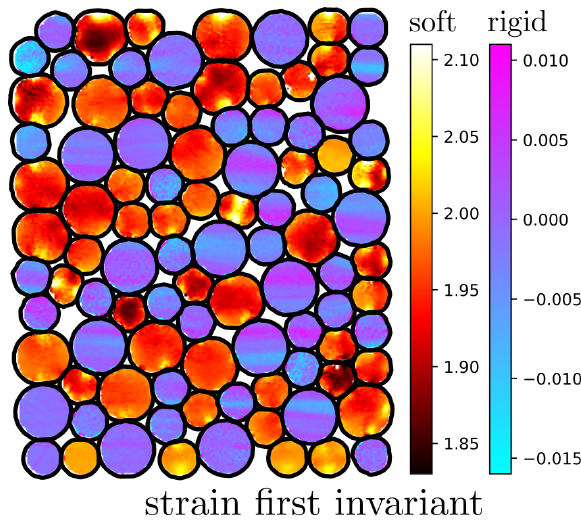
Figure 3. Local observables. Field of the fi rst invariant of the right Cauchy-Green strain tensor ( C ) for soft particles and of the in fi nitesimal strain tensor ( ε ) for rigid particles. These fi elds are computed for a compression experiment made with 50% of rigid particles at a packing fraction φ = 0 . 89 far above the jamming point.